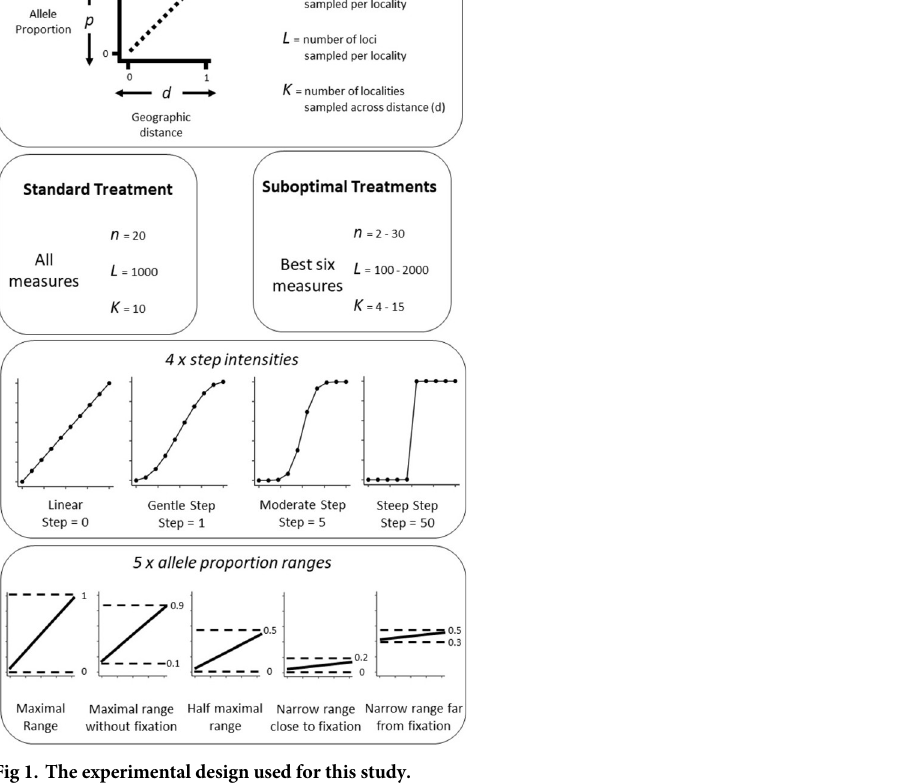
Fig 1. The experimental design used for this